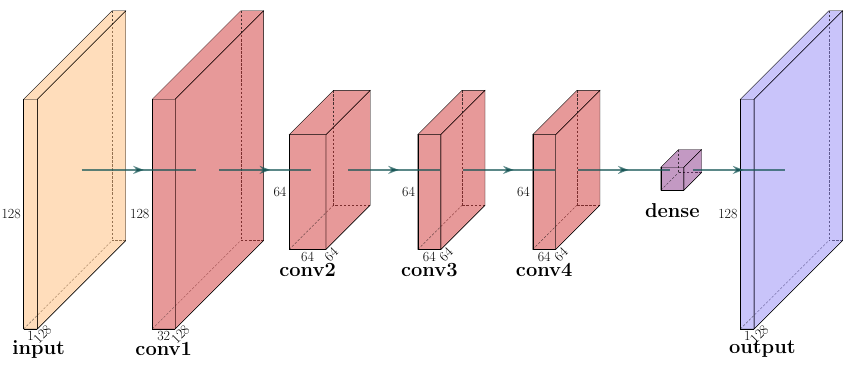
Figure 15. The network structure of discriminator in WGAN-GP. Conv is the abbreviation of convo- lutional. LN is the abbreviation of layer normalization. LeakyReLu is activation function. The structure of the VAE is shown in Figure 16.